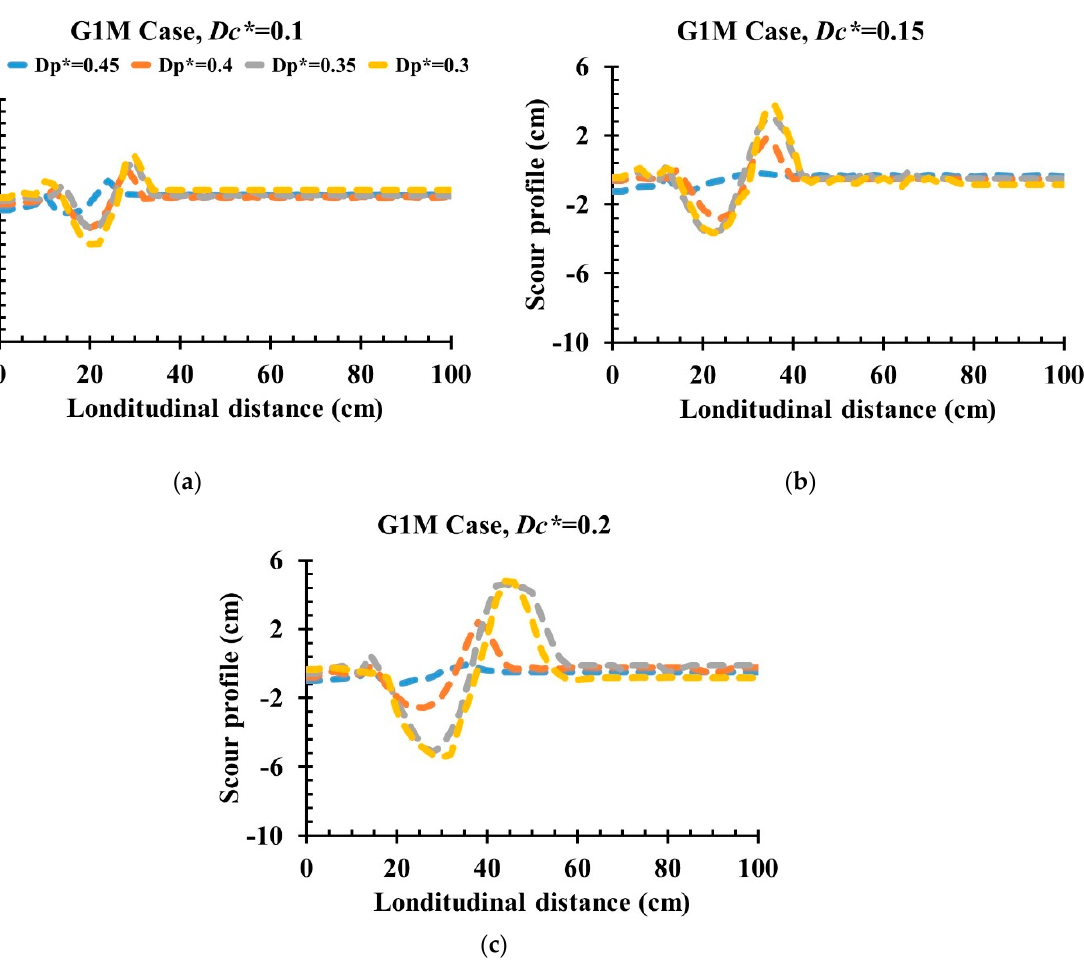
Figure 6. ( a ‐ c ) Scour profile during G1M case: (geogrid.1 case with aperture 6.5 mm): ( a ) 𝑫 𝒄 ∗ = 0.1; ( b ) 𝑫 𝒄 ∗ = 0.15; ( c ) 𝑫 𝒄 ∗ = 0.2.